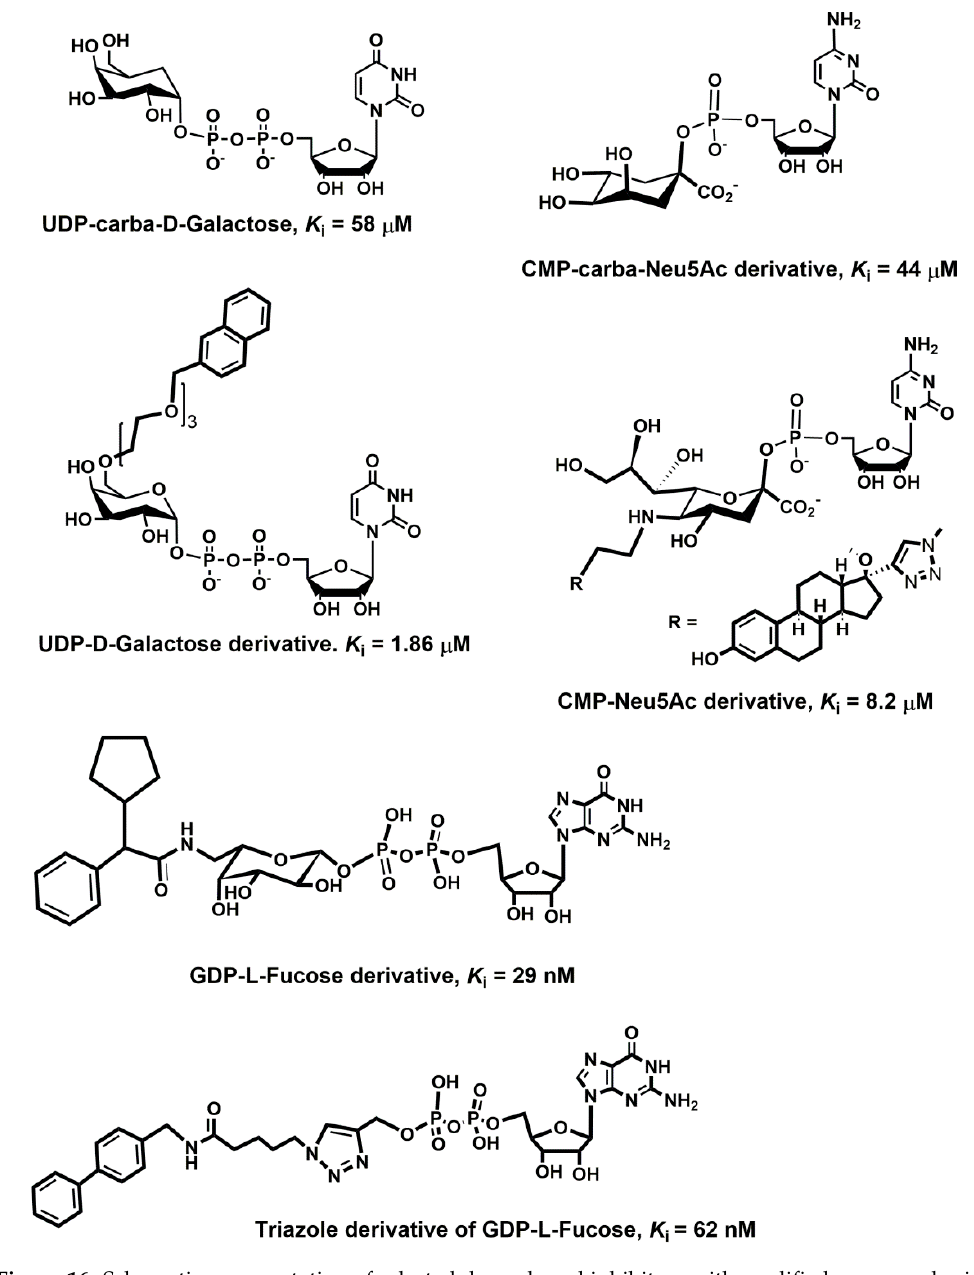
Figure 16. Schematic representation of selected donor-based inhibitors with modified monosaccharide residue UDP-carba-Gal [407], UDP-Gal derivative [408], CMP-Carba-Neu5Ac [409], CMP-Neu5Ac [410], Triazol derivative of GDP-Fuc [400], and GDP-Fuc [401].